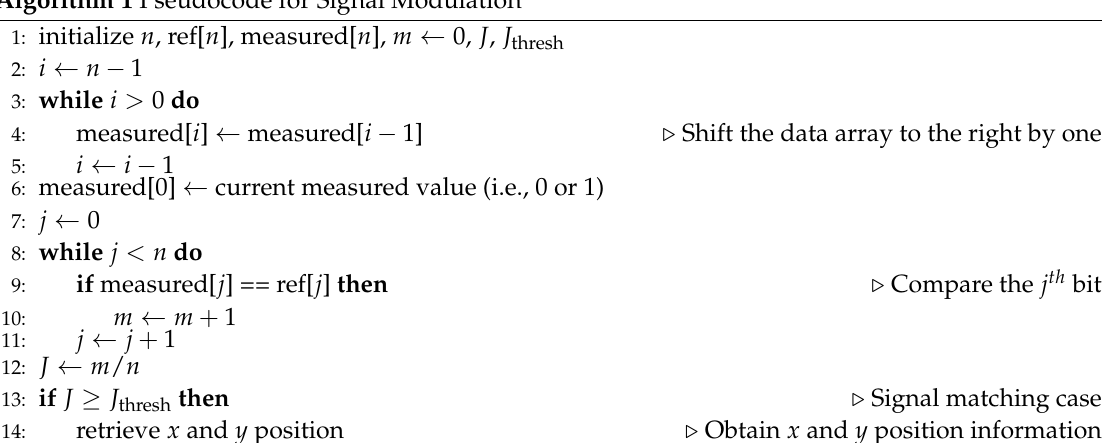
Algorithm 1 Pseudocode for Signal